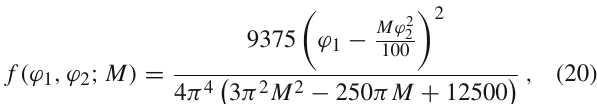
same initial particle type are coupled directly to each other in the two-particle